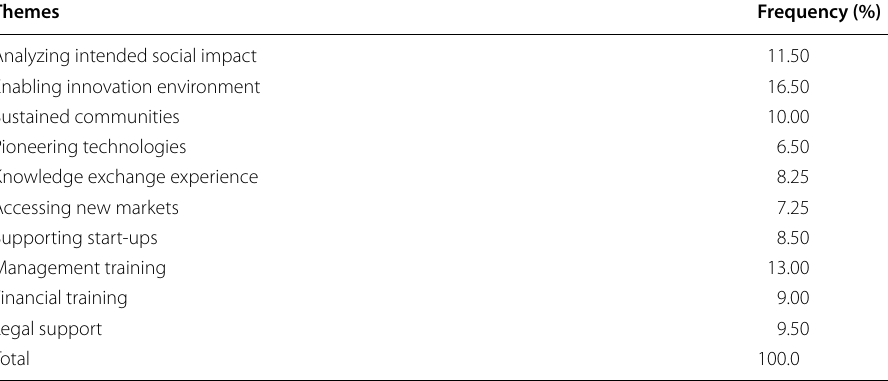
Table 4 Antecedents’ main themes describing the organizations’ two-liner mission according to their